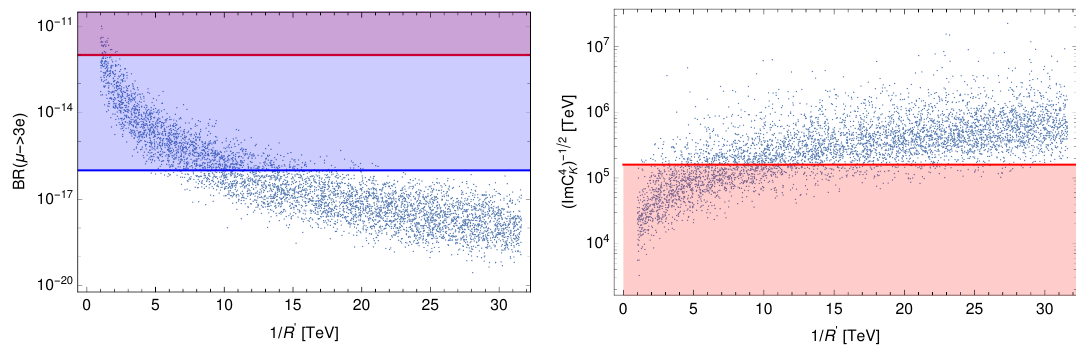
Figure 2 . Current (red) and future (blue) constraints on the µ → 3 e decay (left) and ( Im C 4 (right), displayed together with the predictions of our scan as a function of 1 /R 0